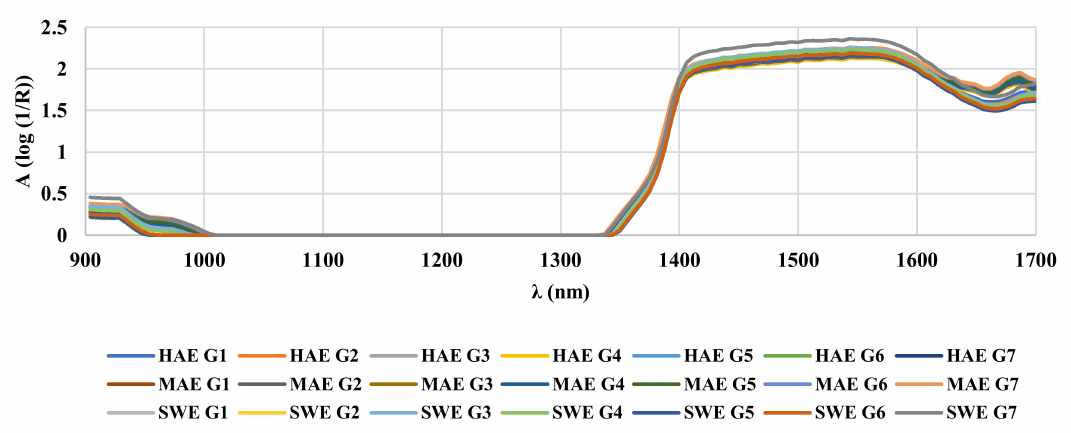
Figure 1. NIR spectra of ground ivy extracts.